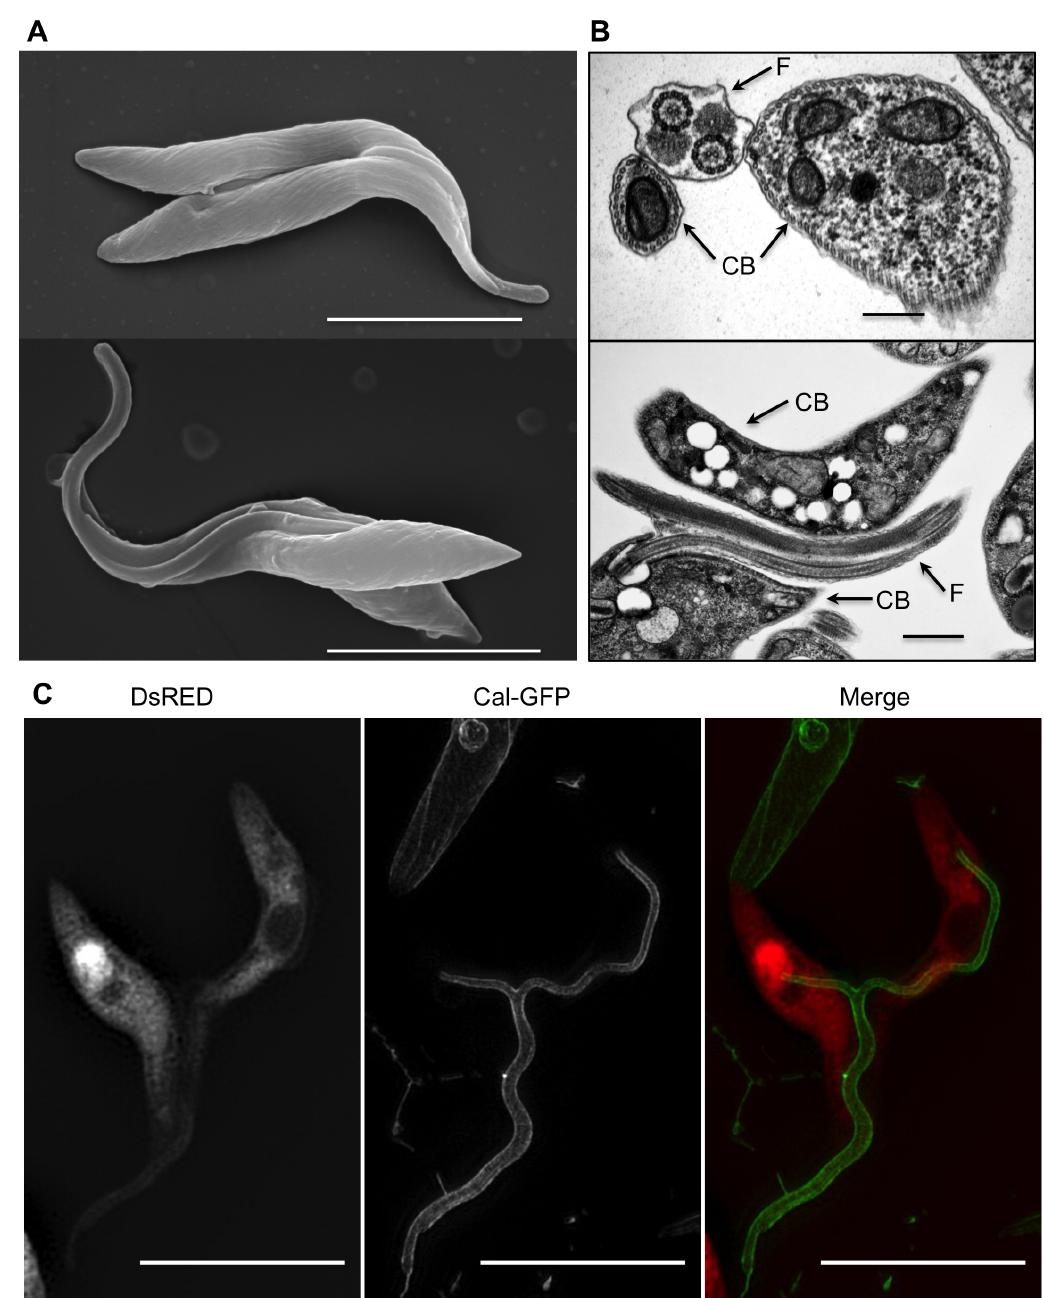
Figure 7. High-resolution images of interacting trypanosomes. A : Scanning electron microscopy of interacting trypanosomes ( Δ proc). The scale bar indicates 10μm. B : Transmission electron microscopy of fused flagella ( Δ proc). The scale bar indicates 0.5μm for the upper image and 1.5μm for the lower image; arrows indicate the cell-body (CB) and the flagellum (F). C : Structured illumination microscopy (SIM) of interacting trypanosomes with fused flagella. Trypanosomes were tagged with either DsRED ( Δ proc) or calflagin44-GFP (WT). The scale bar indicates